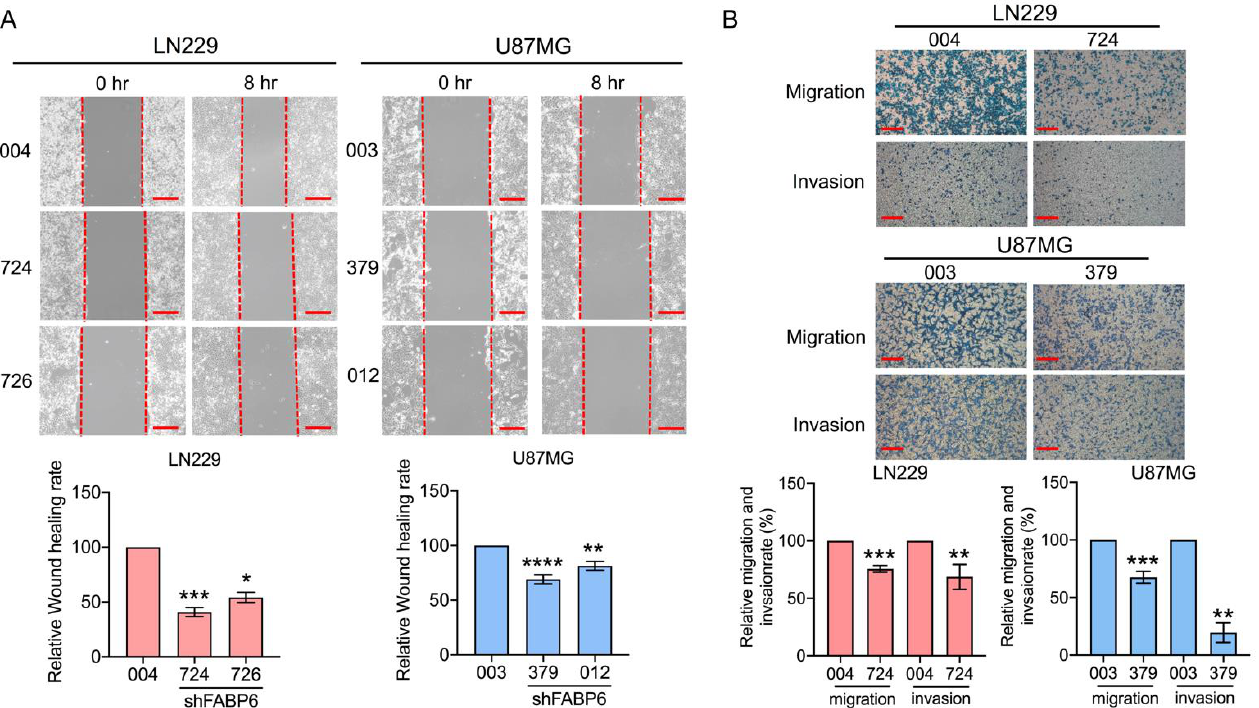
Figure 2. The migration and invasion abilities after the inhibition of FABP6: ( A ) Wound healing migration assays were performed in two human glioma cell lines, LN229 ( n = 6) and U87MG ( n = 7), after 8 h scratch. ( B ) Transwell migration assays were performed in the LN229 and U87MG cells after 16 h incubation. Thereafter, the cells were stained and captured. * p < 0.05; ** p < 0.01; *** p < 0.001; **** p < 0.0001 compared with the shScramble control group (004 in LN229 cells and 003 in U87MG cells). The lower panel displays the relative rate of the transwell migration ability compared to that of the control: 004 and 003 are the shScramble control groups in LN229 and U87MG, 724 and 726 in LN229 cells, and 379 and 012 in U87MG cells were the shFABP knockdown groups. Scale bar = 200 m.